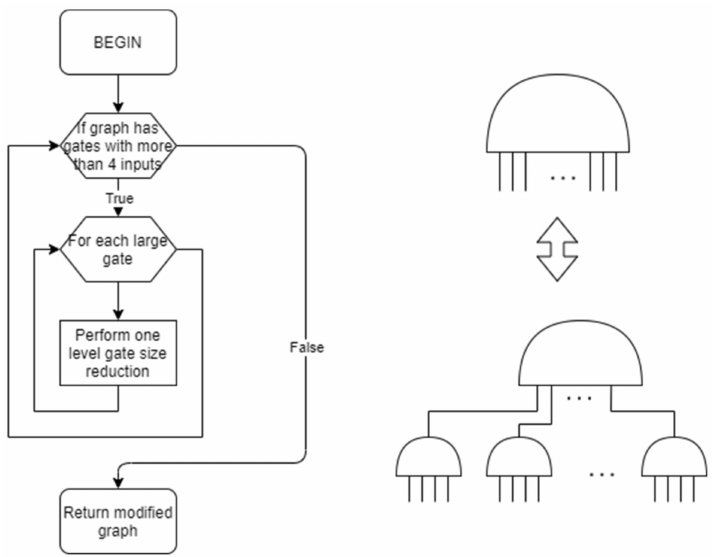
Figure 7. A gate size reduction for the whole graph algorithm ( left ) and an example of one level gate size reduction ( right ). Redundant nodes removal.